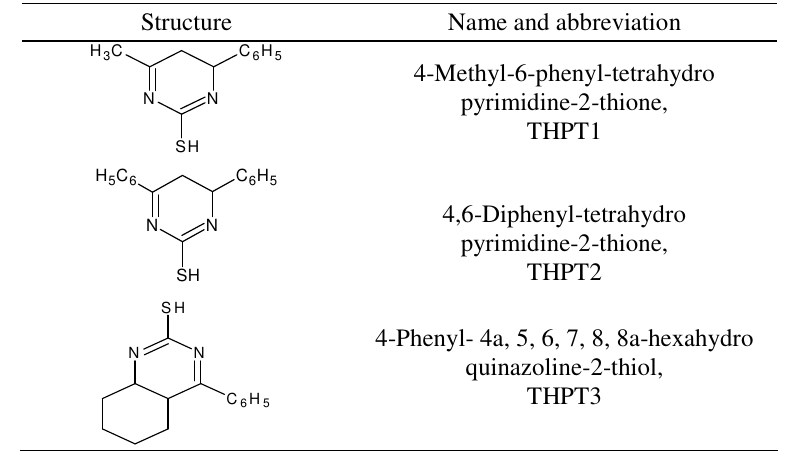
Table 1. Molecular Structure of the